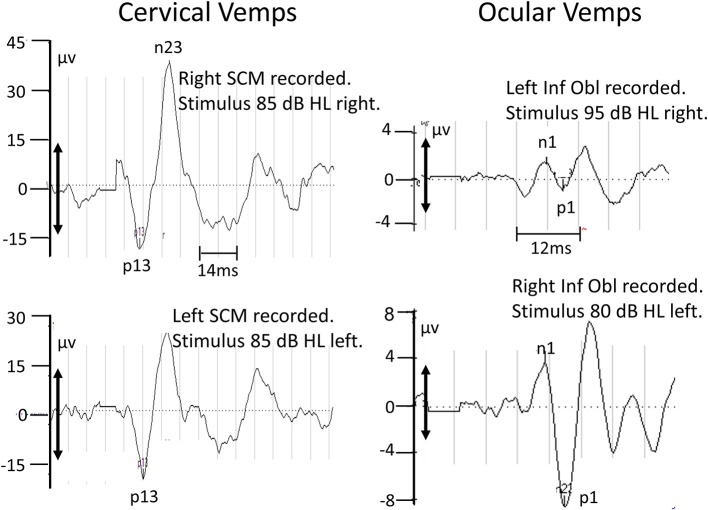
Recordings of c-VEMPs (left panels) and o-VEMPs (right panel) taken 1 and 6.9 months after acute onset of symptoms, respectively. The upper 2 sets of traces are for right ear stimulation, the lower 2 sets for left ear stimulation. The air-conducted (500 Hz) stimulation level was increased to 95 dB to elicit right o-VEMPs. The double-headed arrows on the ordinates indicate the minimum VEMP amplitude (28.6 μV for c-VEMPs, 5.2 μV for o-VEMPs) necessary to define a normal response (above the lower 5% limit of normal control subjects; (27)]. Based on these criteria the right o-VEMPs are not normal.